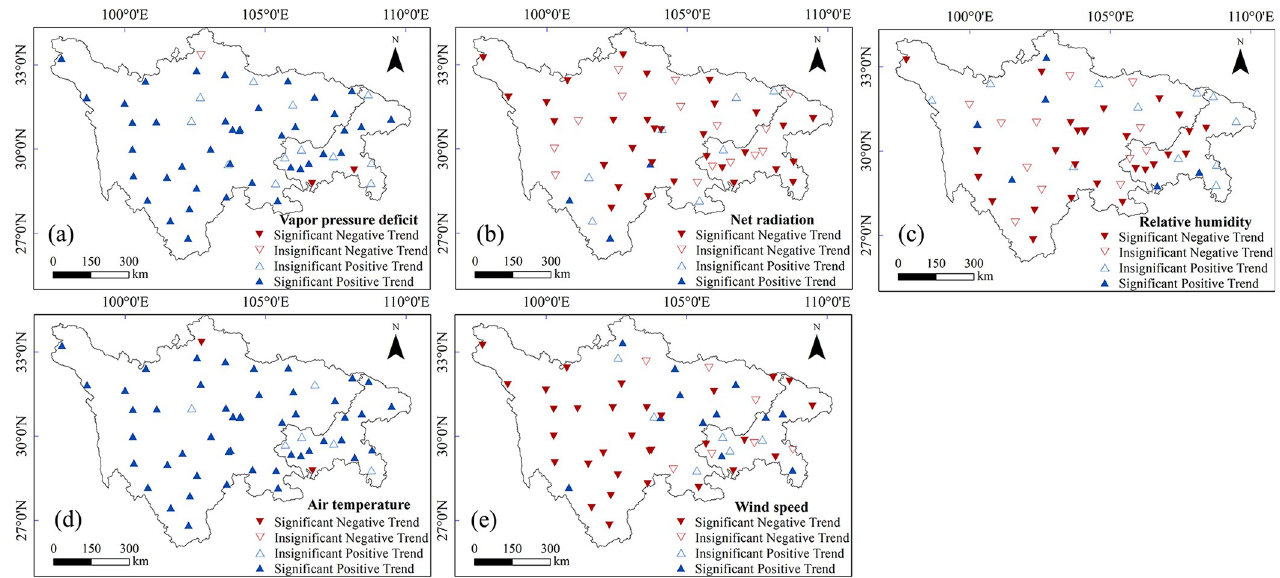
Fig 5. Spatial distributions of changes in climatic factors ((a) vapor pressure deficit, (b) net radiation, (c) relative humidity, (d) air temperature and (e) wind speed). Blue upward and red downward triangles represent positive and negative trends, respectively. Solid triangles indicate trends are statistically significant ( p < 0.05).